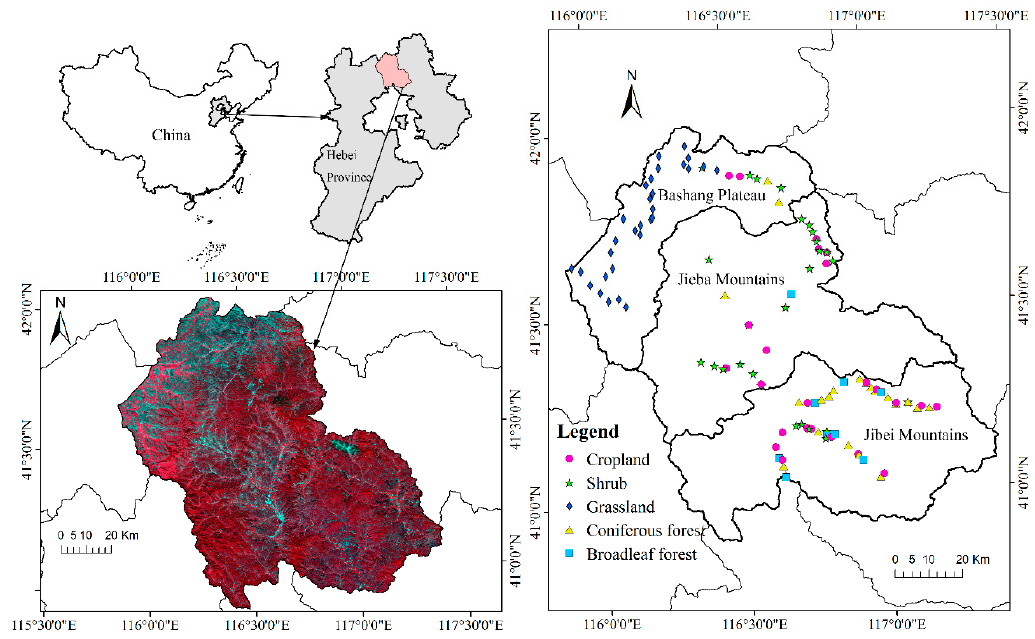
Figure 1. The geographical location of the study area, a GF-1 false- color composite image from GF-1 satellite data, and the distribution of the field survey sites in 2015.